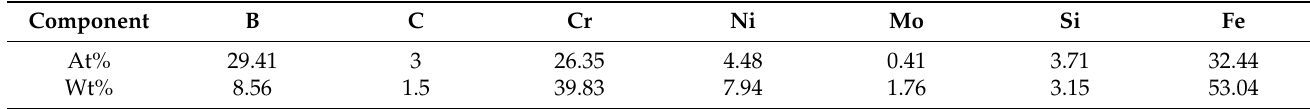
Figure 5. Boride energy spectrum analysis. Table 4. Energy spectrum composition of boride.